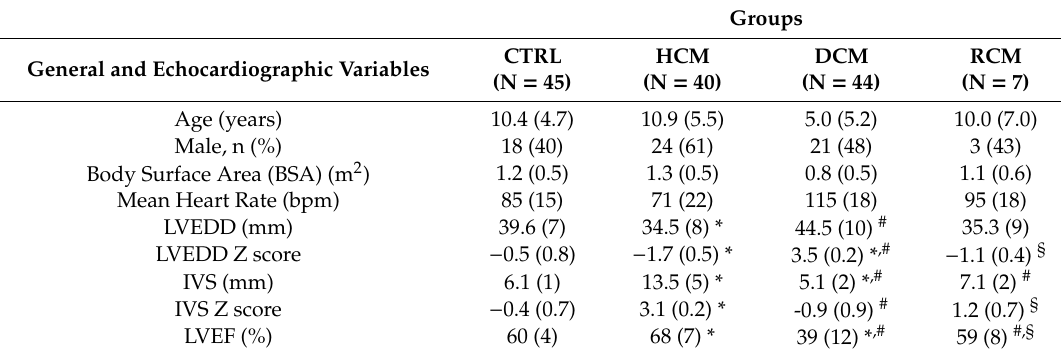
Table 1. General characteristics of the studied